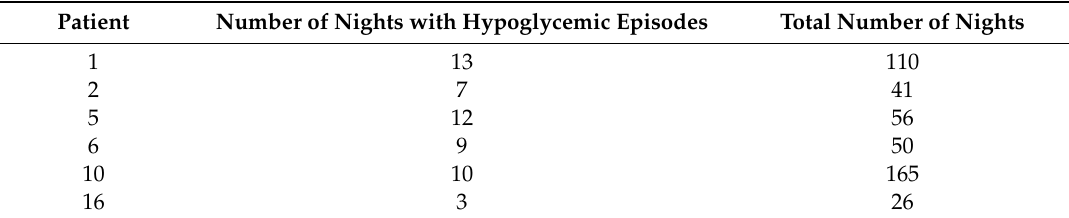
Table 5. Number of nights with at least one hypoglycemic episode compared to the total number of nights.